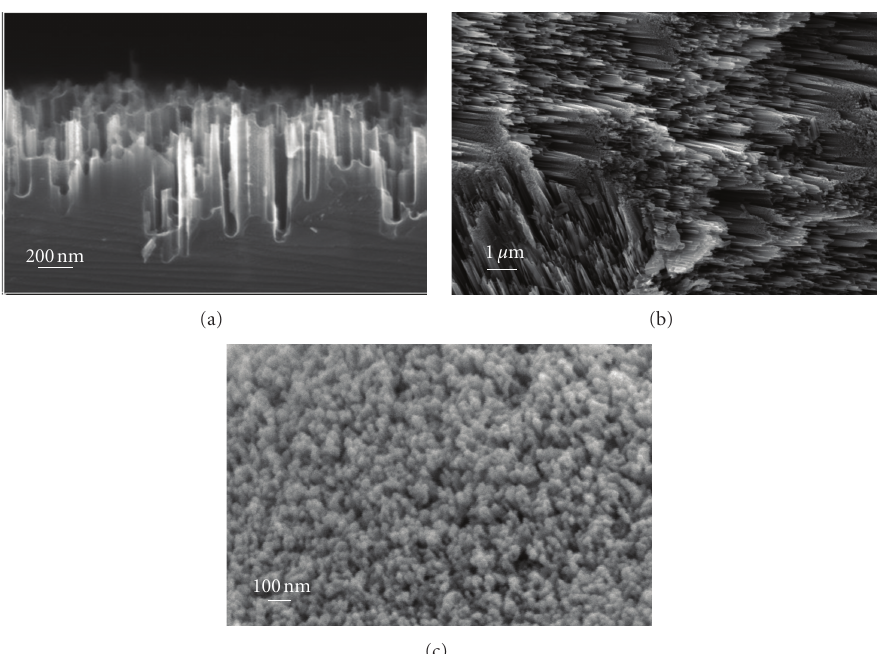
Figure 1: After metal-NP-assisted etching, the random size distribution of Si nanorods on black silicon wafers (BSWs) is averaged. (a) 600nm-thick nanorods formed on (100) silicon wafer. The orientation of nanorods is normal to the silicon surface, revealing that the anisotropic etching is primarily along (cid:4) 100 (cid:5) . (b) The nanorods built on grains with di ff erent crystalline orientations are clearly distinguished. The nanorods have the average length of 1 μ m after etched for 3 min. (c) 100 nm-thick nanorods on mc-BSW after 18s